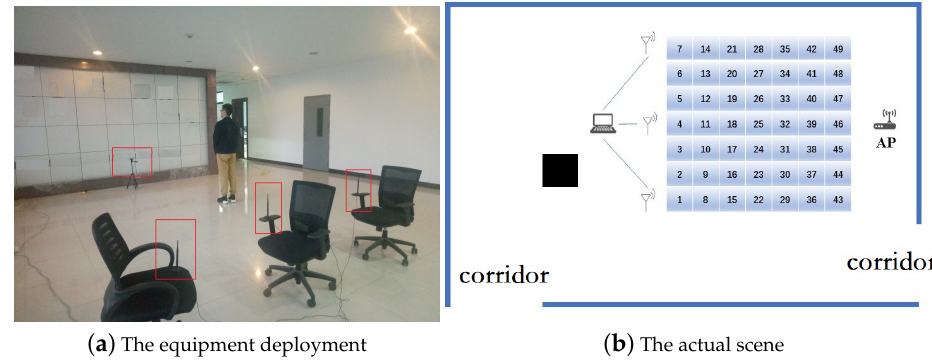
Figure 4. The experimental environment.